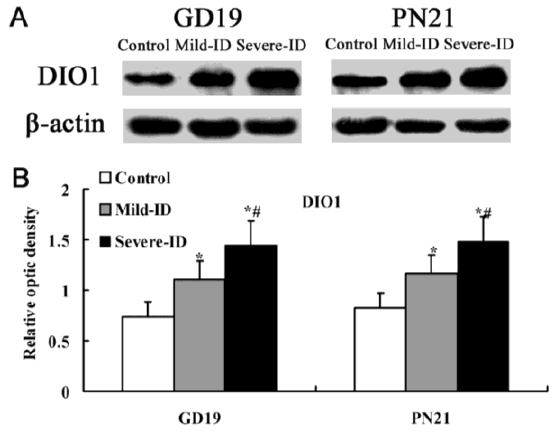
Figure 6. Up-regulated protein levels of DIO1 in the thyroid. The upper bands ( A ) depict representative findings for rats subjected to mild ID and severe ID. The lower bar graphs show the results of the semi-quantitative measurement of DIO1 ( B ) following mild ID and severe ID treatment. The height of each bar represents the mean ±SD for the groups. At each time point, * compared to the control, p < 0.05; # compared to the mild ID, p < 0.05 (n =